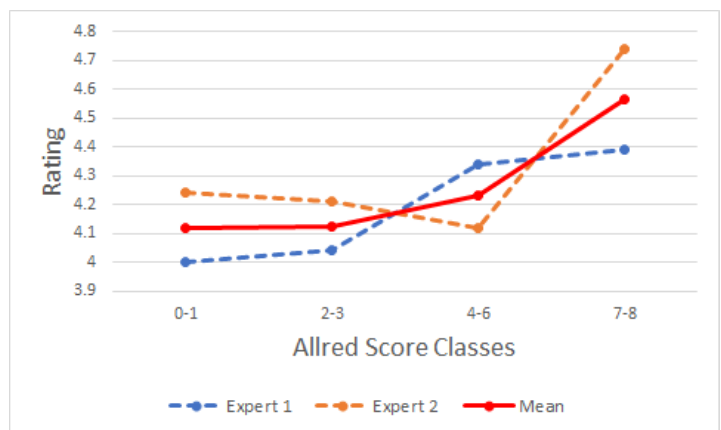
Figure 3. Results obtained from Wnt-1 positive segmentation. The y-axis is not displayed from the origin to improve visualization.